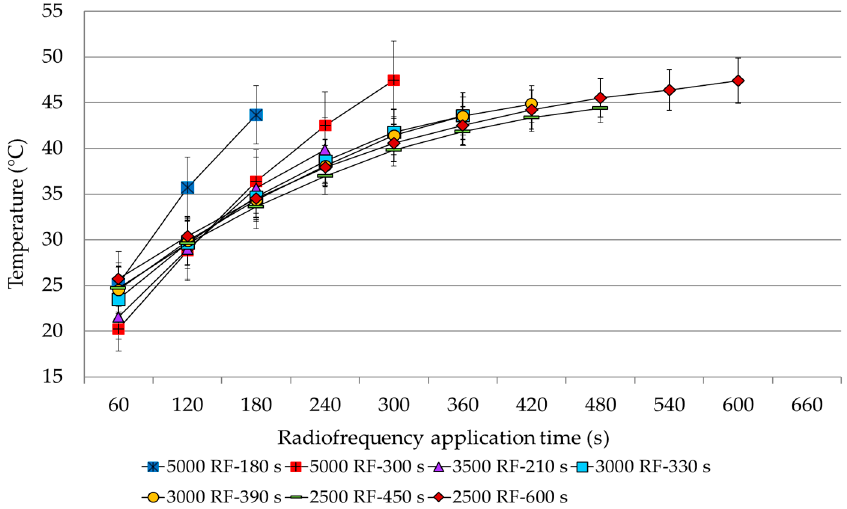
Figure 1. Internal temperature pattern recorded in dates treated with different radio frequency (RF) voltage-time combinations (mean ± Standard Deviation).